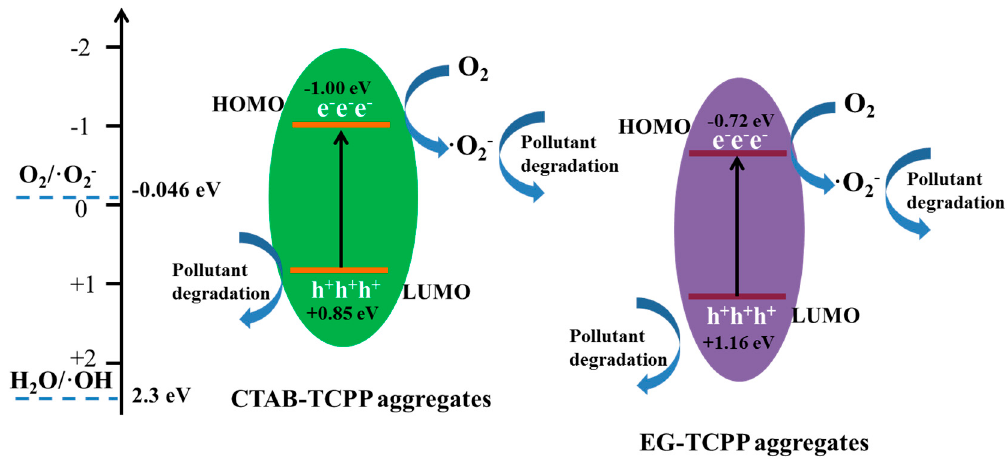
Figure 14. Predicted mechanism diagram of TCPP aggregates for photocatalytic degradation of phenol.